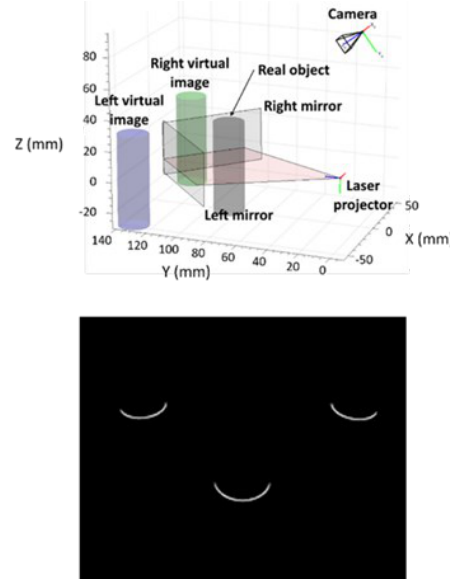
Figure 4: Isometric view of the proposed 360° LTS and a simulated acquired image.